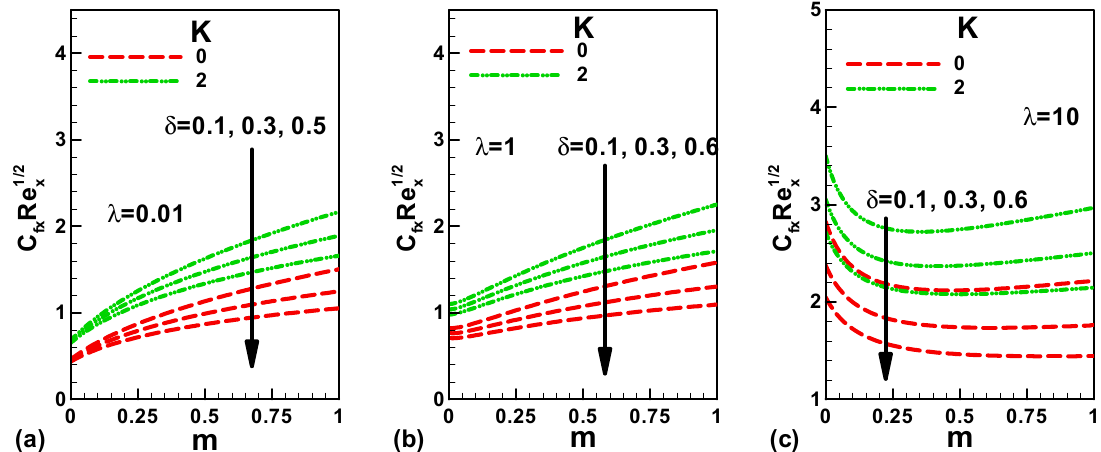
Figure 8. Variation of skin friction with pressure gradient and slip parameters for ( a ) forced convection, ( b ) mixed convection, and ( c ) free convection. [ n = 0.5, Ω = π /6, Rd = 0.5, Da = 100].